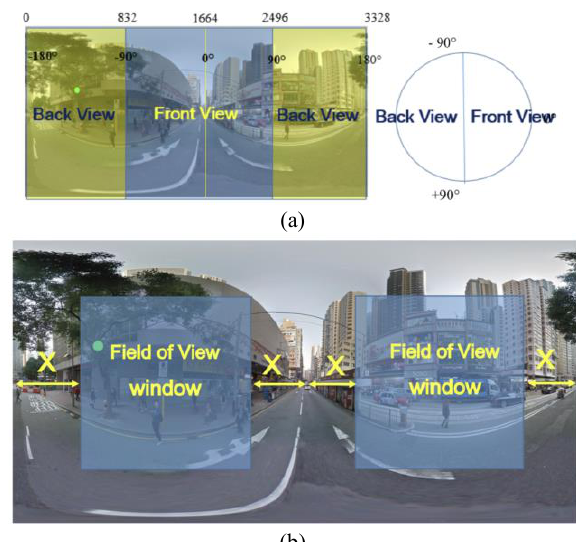
Figure 7.(a) Front view and back view in equirectangular image. (b) window filter with offset setting (X) is applied to